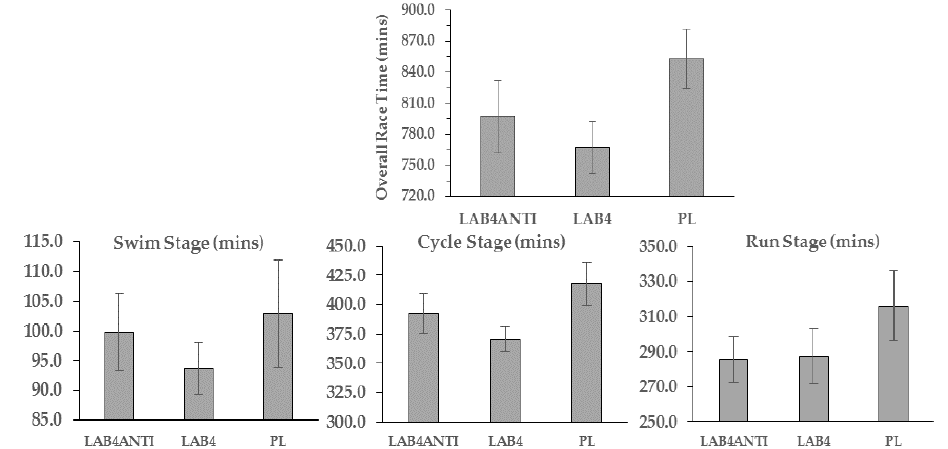
Figure 3. Race time comparisons in minutes (Mean ± SE), including triathlon stage disciplines. No significant differences reported between groups ( p > 0.05). Converted overall times: LAB 4ANTI = 13 h 17 min 07 s (±34 min 48 s); LAB 4 = 12 h 47 min 47 s (±25 min 31 s); PL= 14 h 01 min 40 s (±31 min 32 s).